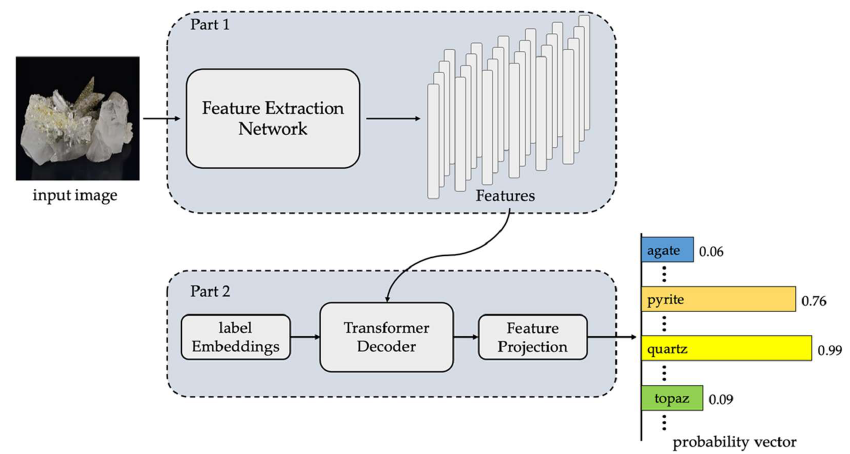
Figure 2. The mineral identification model based on the multi-label image classification. After a mineral image is input into the model, the probability of the presence of each mineral is output.